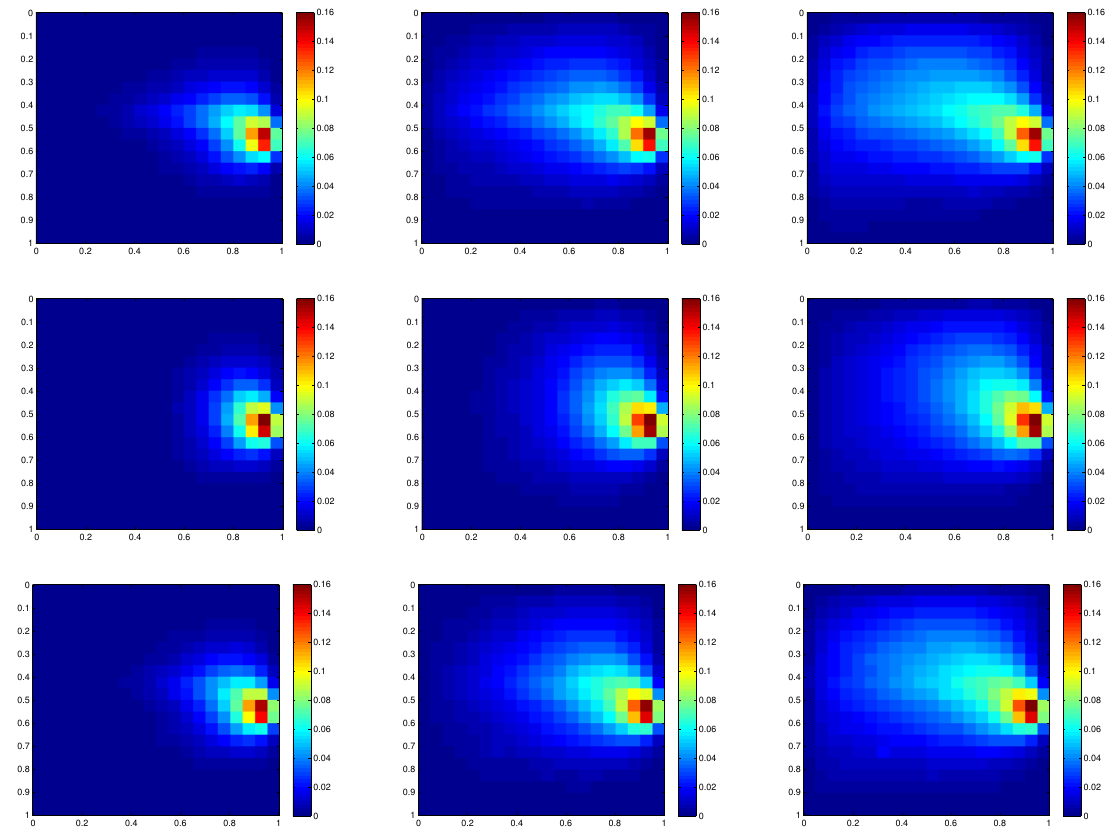
Figure 4. First row: Fine-scale solutions c . Second row: GMsFEM solutions c h multiscale basis function per edge for both velocity and flux-concentration). Third row: GMsFEM solutions c (two multiscale basis function per edge for both velocity and H flux-concentration). From left column to right column: T = 0 . 015 , 0 . 04 , 0 . 1 . We use κ = κ = f , f , H = 1 c 1